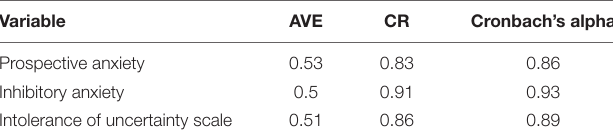
TABLE 3 | Average Variance Extracted and Construct Reliability for two subscales of uncertainty